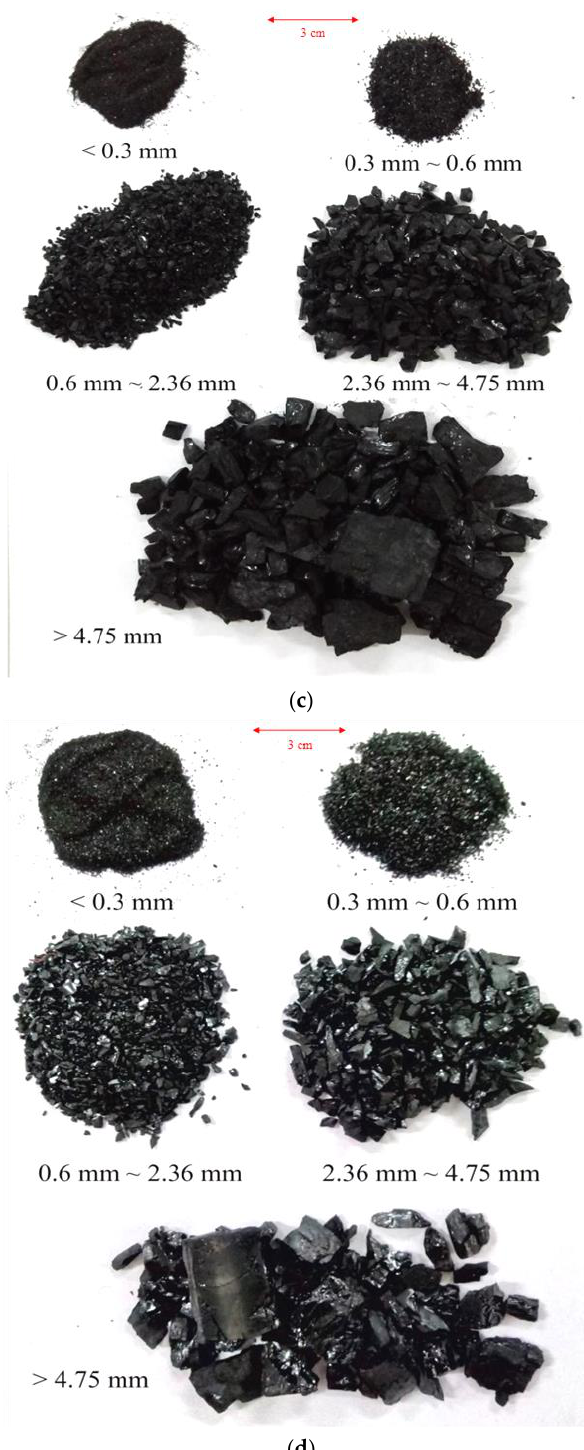
Figure 7. Failure morphology of coal specimens under differential dynamic impact velocities